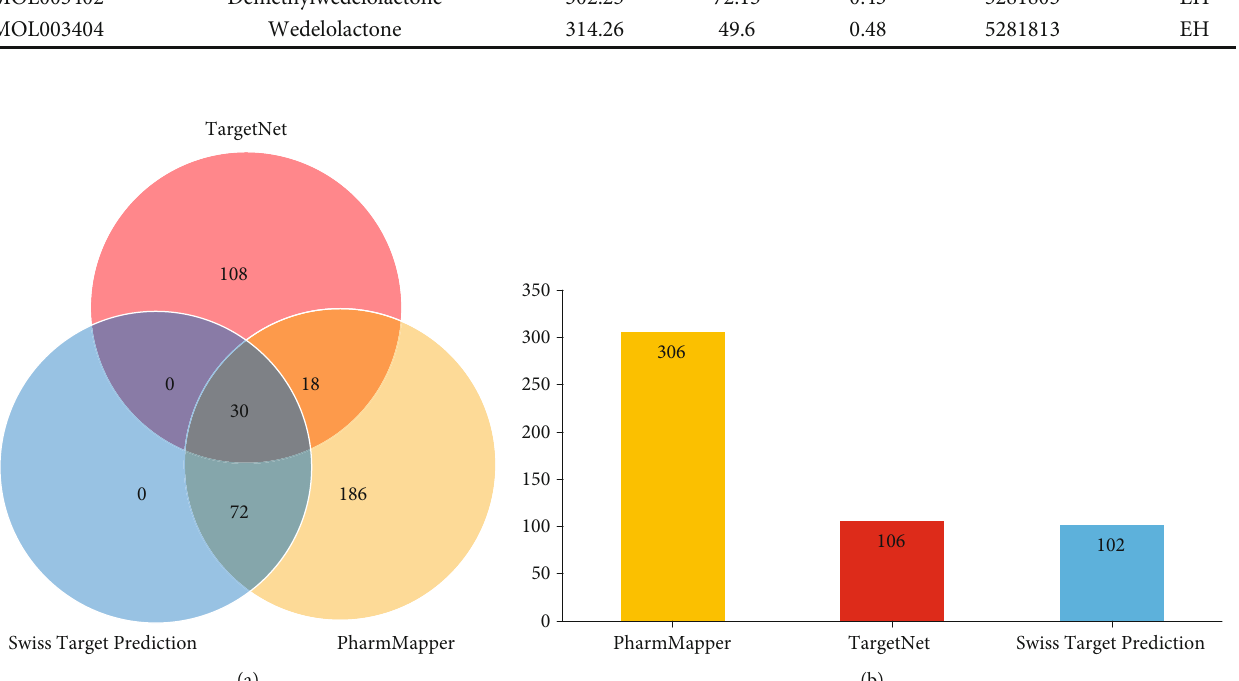
Figure 1: Analysis of predicted genes of potential bioactive compounds of EZP from 3 databases. (a) Venn graph showing the number of the overlapping genes from PharmMapper (yellow), TargetNet (red), and Swiss Target Prediction (blue). (b) The number of predicted genes from each